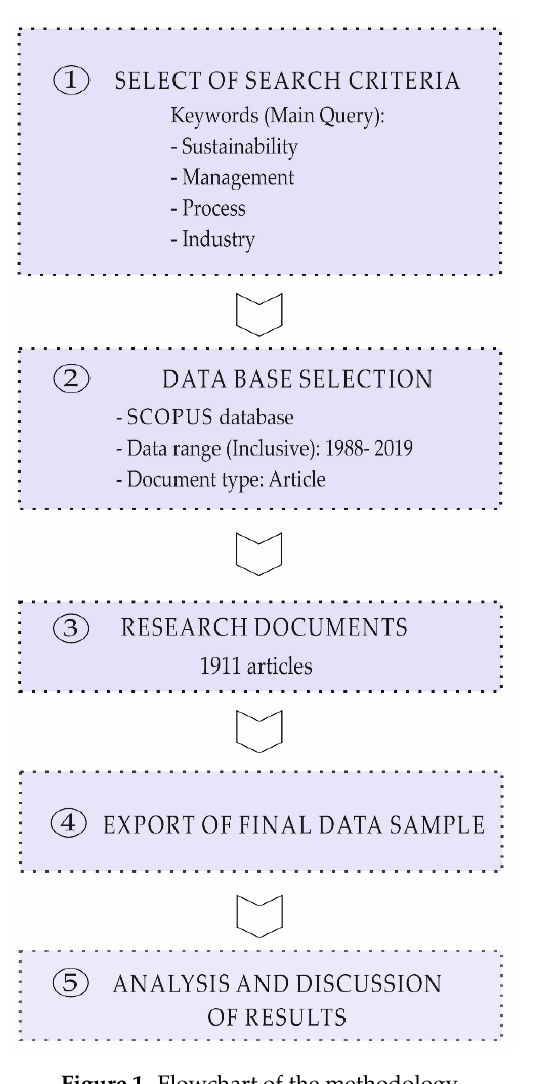
Figure 1. Flowchart of the methodology.